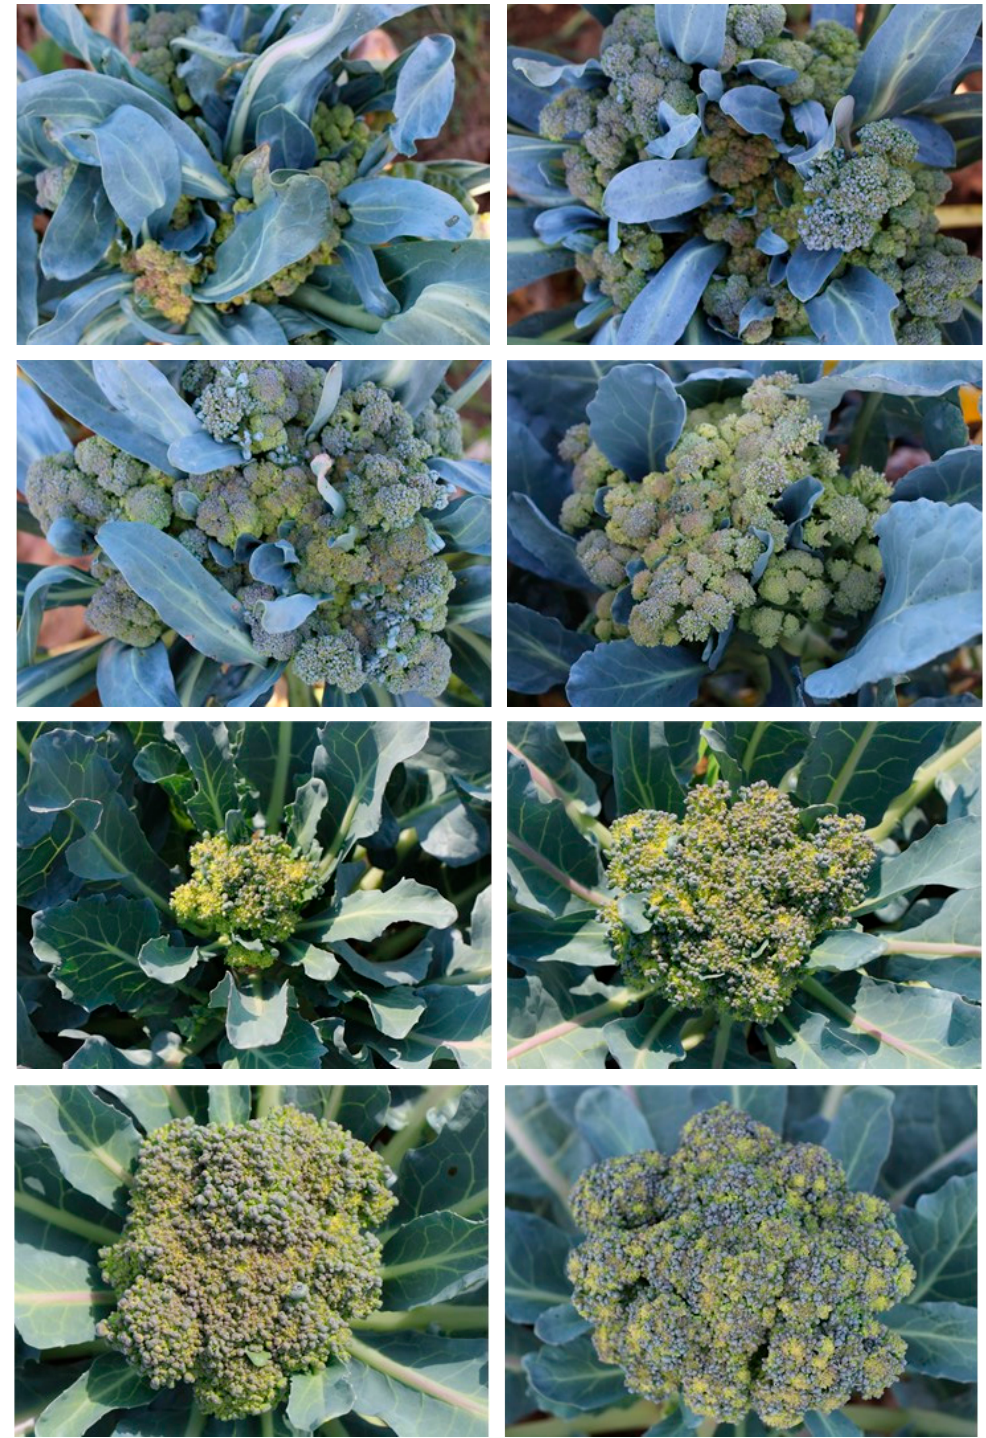
Figure 2. Some of the changes in broccoli head’s characteristics due to heat stress that degrade its quality: uneven flower bud size, presence of leaves between the flower buds, as well as uneven surface, undesirable coloration and smaller head diameter and weight. The above was observed during the cultivation of three F1 hybrids (Cigno, Principe and Domino) at the Farm of the University of Thessaloniki in the period 7.6–18.8.2021 (Cigno, absolute minimum, average and absolute maximum air temperature 15.3, 27.8 and 41.7 °C, respectively) and 7.6–13.10.2021 (Principe and Domino, absolute minimum, average and absolute maximum air temperature 10.7, 26.2 and 41.7 °C, respectively). Table 2. High temperatures cause a wide range of changes in the plant morphology, cultivation, as well as the yield and quality of the crop.